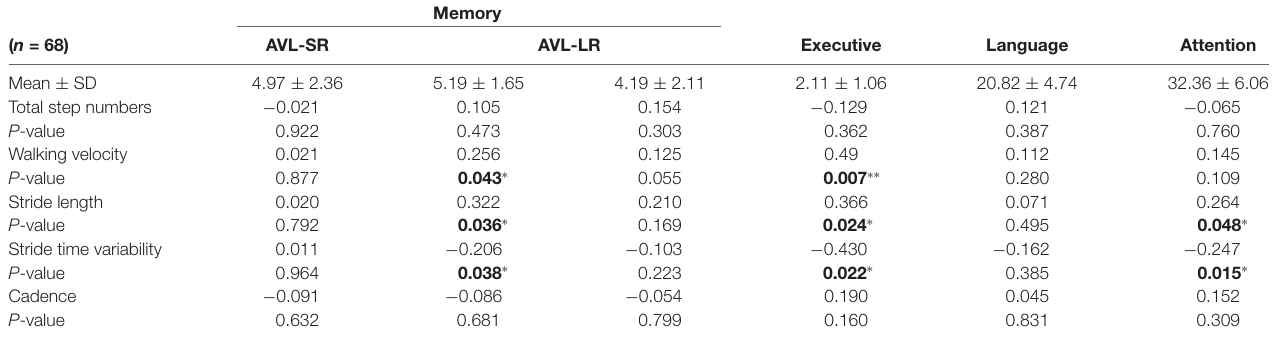
TABLE 3 | Correlations of cognitive domains between gait patterns for all